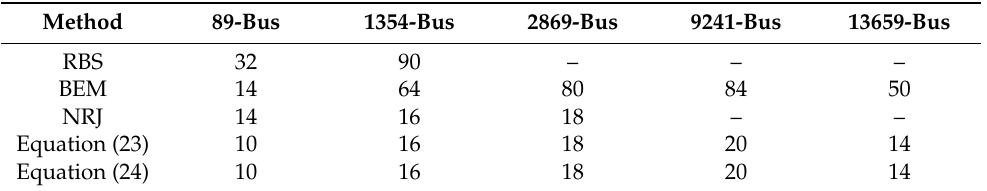
Table 8. Total factorizations with reactive limits.